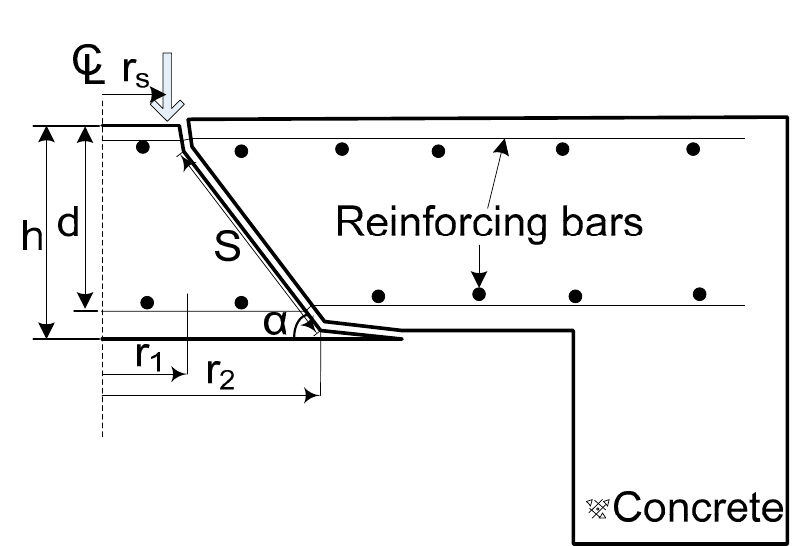
Figure 9. A scheme of the mechanism of punching shear failure.